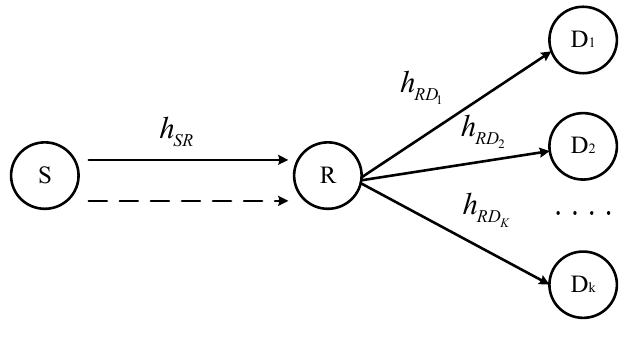
Figure 1. System model.